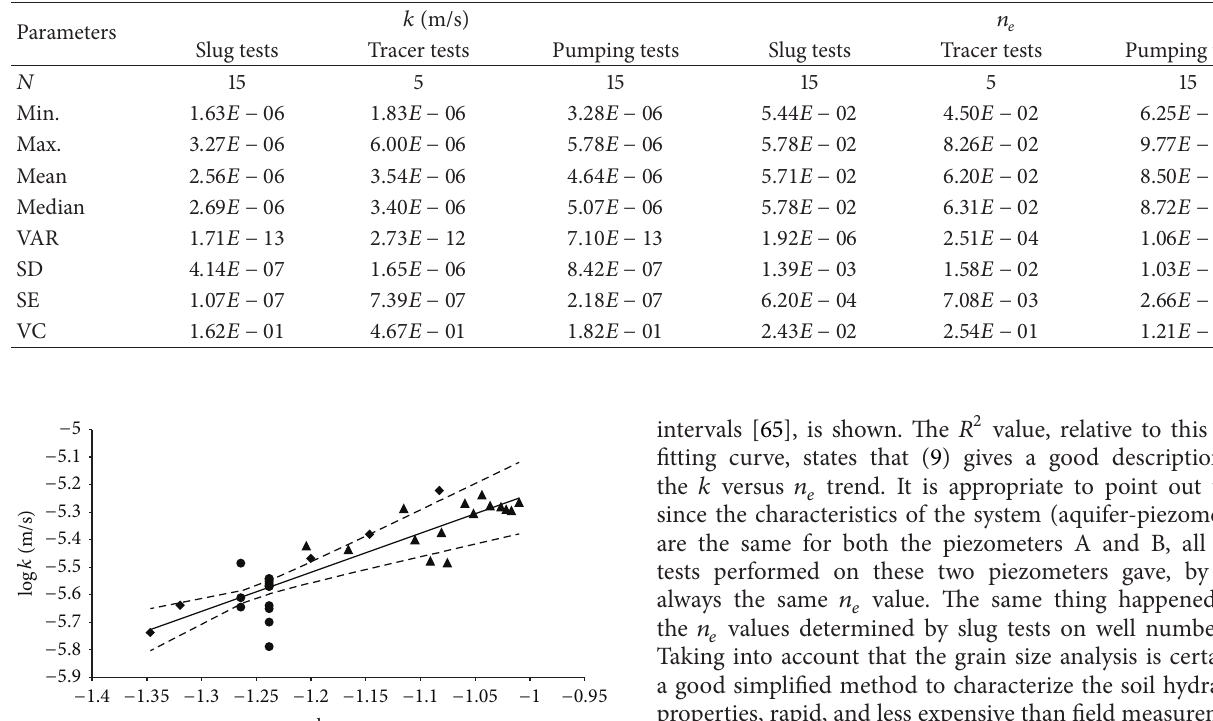
Table 3: Meaningful statistical parameter values characterizing the considered data sets of hydraulic conductivity ( 𝑘 ) and effective porosity ( 𝑛 𝑒 ).